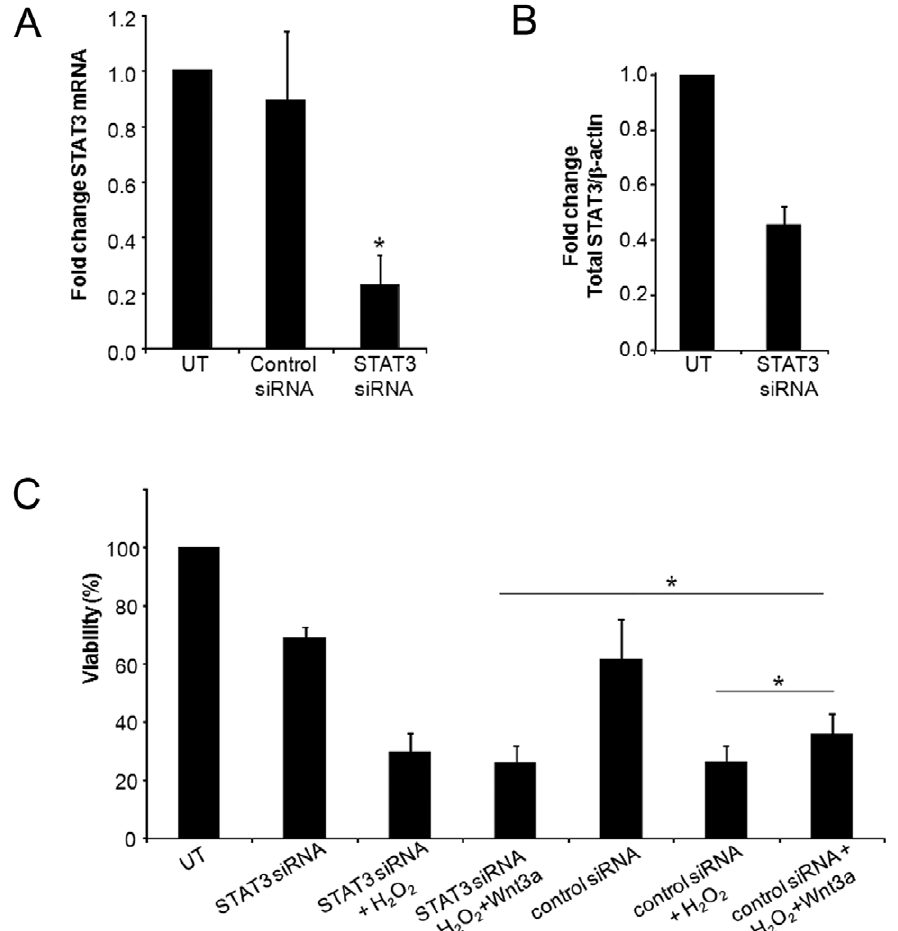
Figure 5. Reducing STAT3 expression eliminated Wnt3a-mediated protection against oxidative stress. (A–B) Efficient reduction of STAT3 expression by siRNA. The cells were transfected with siRNA and STAT3 expression was measured by (A) QPCR (n=3) and (B) Western blotting (n=2), and normalized to untransfected cells. *p , 0.05. C) The cells were transfected with STAT3 siRNA or a control scrambled siRNA and then were treated with H 2 O 2 (0.8 mM for 5 hr) with and without Wnt3a. Viability was measured with Cell Titer Blue and normalized to untreated cells (UT). The rescue effect by Wnt3a was eliminated in the presence of STAT3 siRNA but was observed in the presence of control siRNA (n=3, *p ,